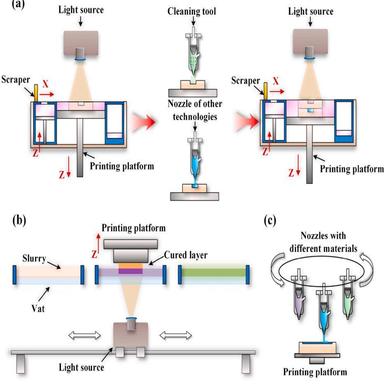
Multi-material additive manufacturing strategy for ceramics.